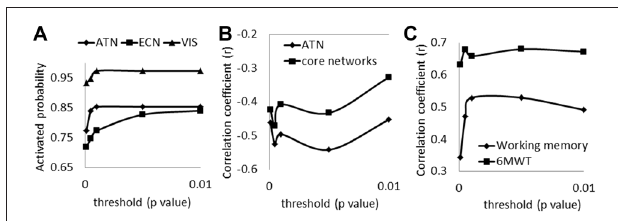
FIGURE 5 | (A) The possibilities of being activated from all scans for the three core networks under different thresholds (ATN, attention network; ECN, left executive network; VIS, visual network); (B) correlations of the number of activated networks with the GM volumes in ATN and with the GM volumes in the total three core networks under different thresholds; (C) correlations of compensatory capacity with working memory function and with 6MWT under different thresholds (6MWT, 6-min walking